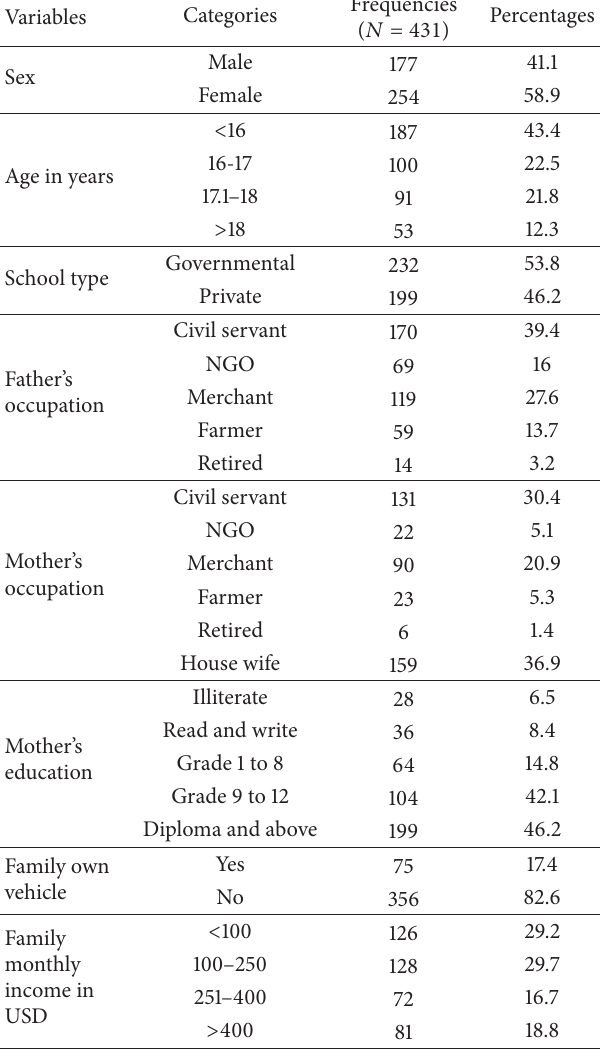
Table 1: Sociodemographic characteristics of the high school students in Bahir Dar city, North West Ethiopia,